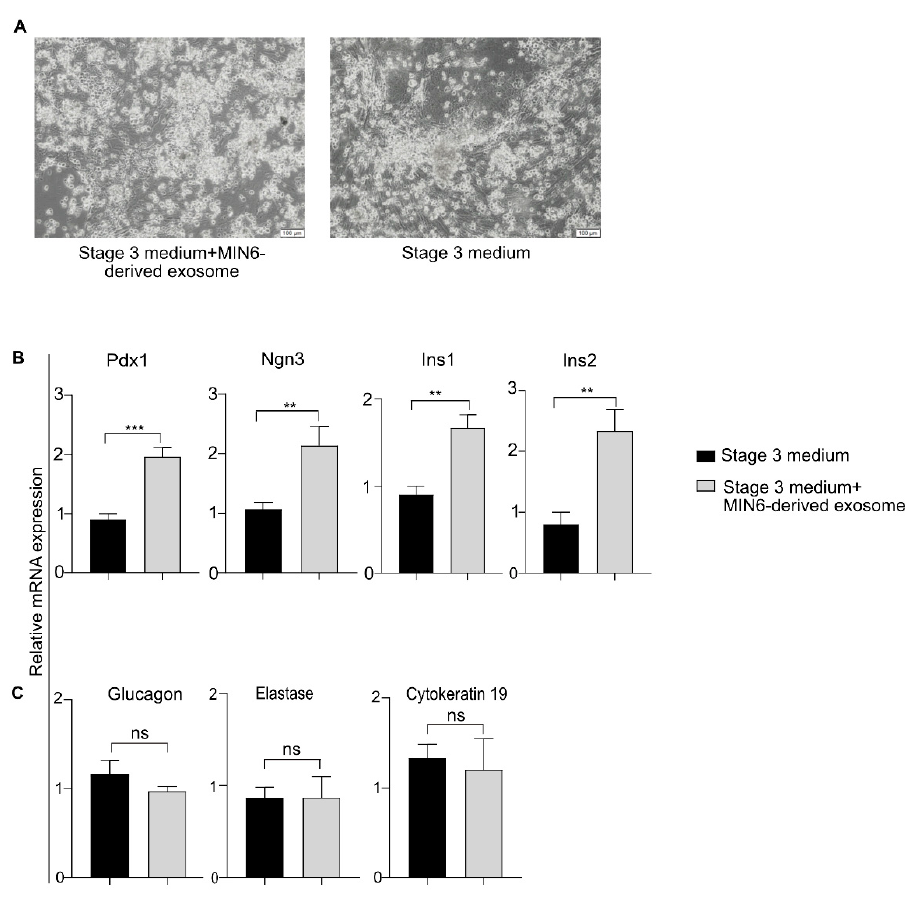
Figure 5. Differentiation of primary mouse exocrine cells into β -like cells using MIN6-derived exosomes. ( A ) Bright-field images of exocrine cells grown in stage 3 medium with or without 50 µg of MIN6-derived exosomes. Scale bar = 100 µm. ( B ) qRT-PCR analysis of pancreatic β -cell markers. ( C ) Gene profiling of α , acinar, and ductal cell-specific genes using qRT-PCR. Data are expressed as the mean ± SEM of 3 independent experiments. ** p < 0.01, *** p < 0.001 (student’s t -test) between groups. Ins1 and Ins2 refer to the Insulin-1 and Insulin-2 transcripts, respectively. ns = non-significant.